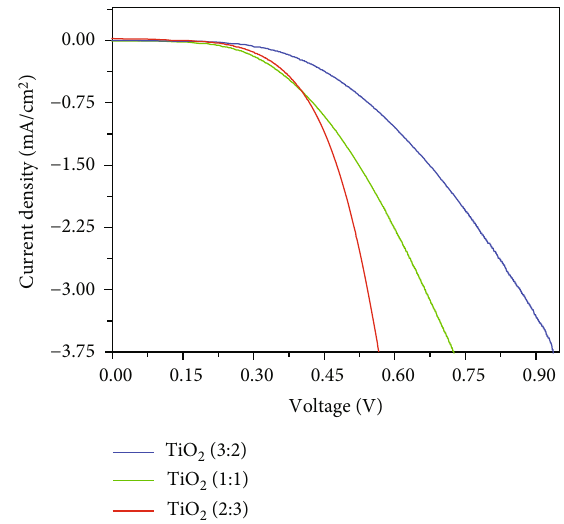
Figure 12: J-V curves of root of Knipho fi a schemperi dye- fi lled NPs in volume ratios of (a) 2: 3, DSSCs using biosynthesized TiO 2 (b) 1:1, and (c)